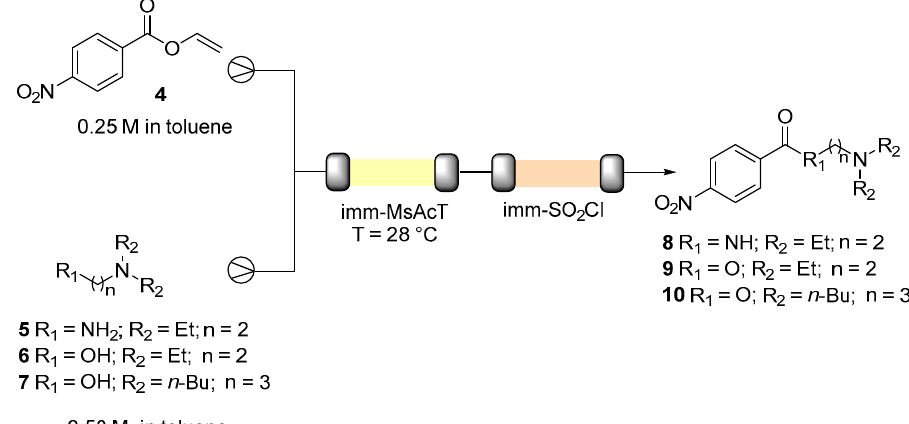
Scheme 1. Reaction conditions: 0.25 M solution of 4 in toluene, 0.5 M solution of the nucleophile ( 5 , 6 ,